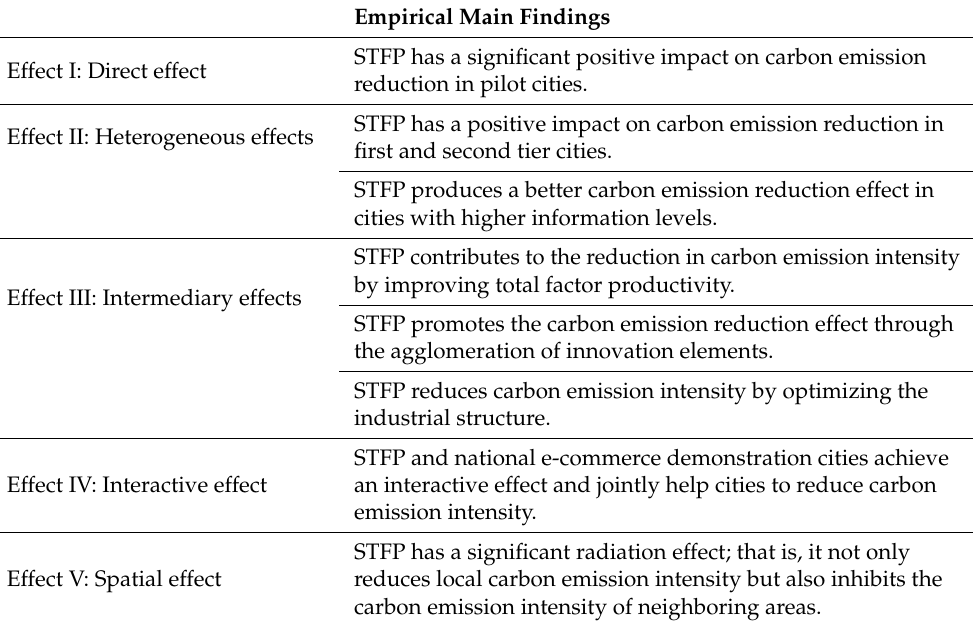
Table 11. Summary of results: five impacts of STFP on carbon emission